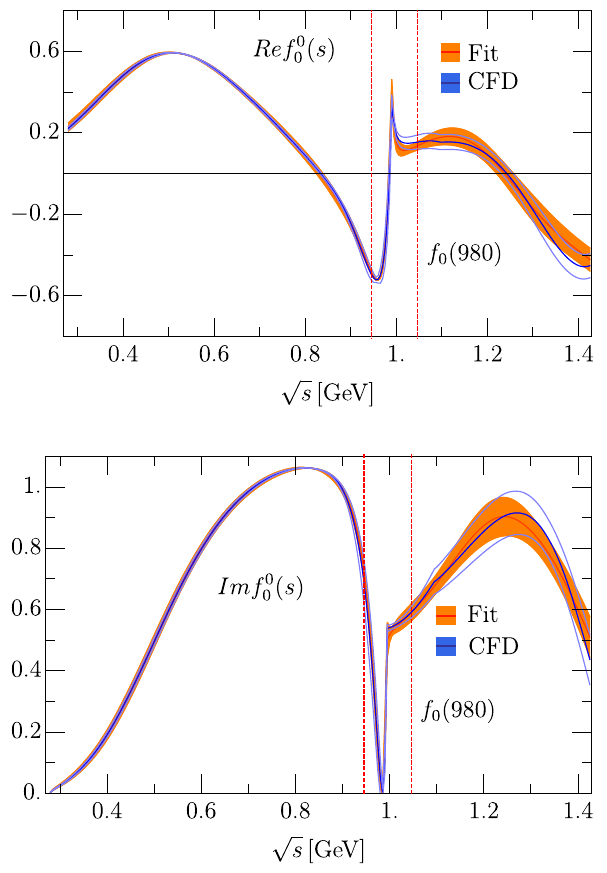
Fig. 2 Comparison between the CFD fit in [28] (blue) and solution I (Table 1, orange band). The energy region dominated by the f 0 ( 980 ) pole is delimited between the red dashed lines